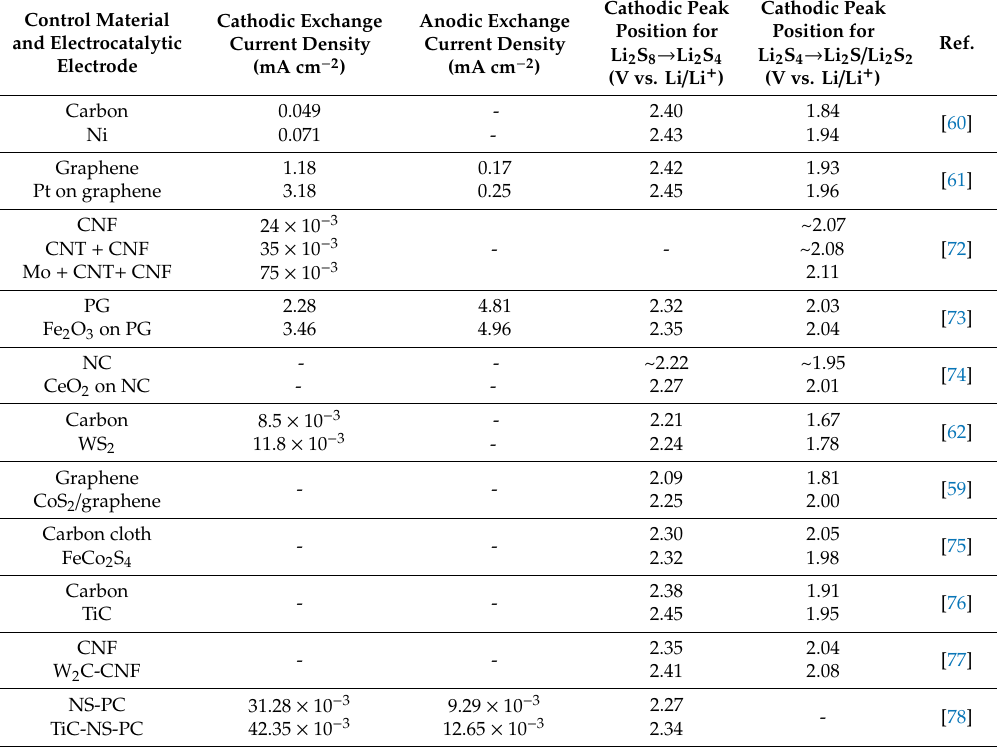
Figure 4. Left top: Illustration of synthesis of S@Co-Fe-P nanocubes. Right: Second cycle CV curves of S@Co-Fe-P and S@Co-Fe cathodes at a scan rate of 0.1 mV s − 1 . Left Bottom: Long cycling performance and coulombic efficiency of S@Co-Fe-P cathode at 1 C rate. Reproduced with permission, Copyright, 2019, American Chemical Society [71] . Table 1. Summary of cathodic and anodic exchange current densities ( i 0 ), cathodic peak positions observed during cyclic voltammetry (CV) studies for various electrocatalysts. CNF—carbon nanofiber; CNT—carbon nanotube; PG—porous graphene; NS-PC-Nitrogen and sulfur co-doped porous